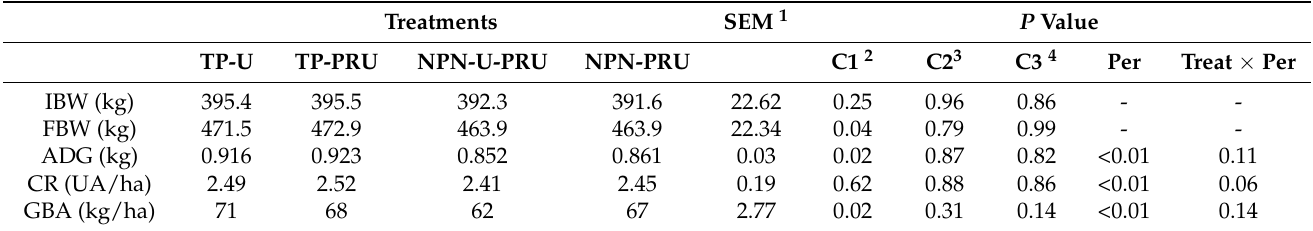
Table 8. Performance of grazing Nellore cattle during the seasonal receiving different types of